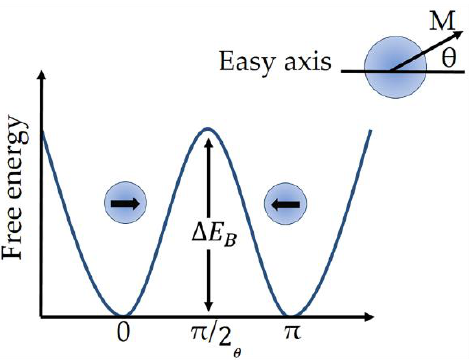
Figure 4. Evolution of the magnetic energy with the tilt angle between the easy axes .